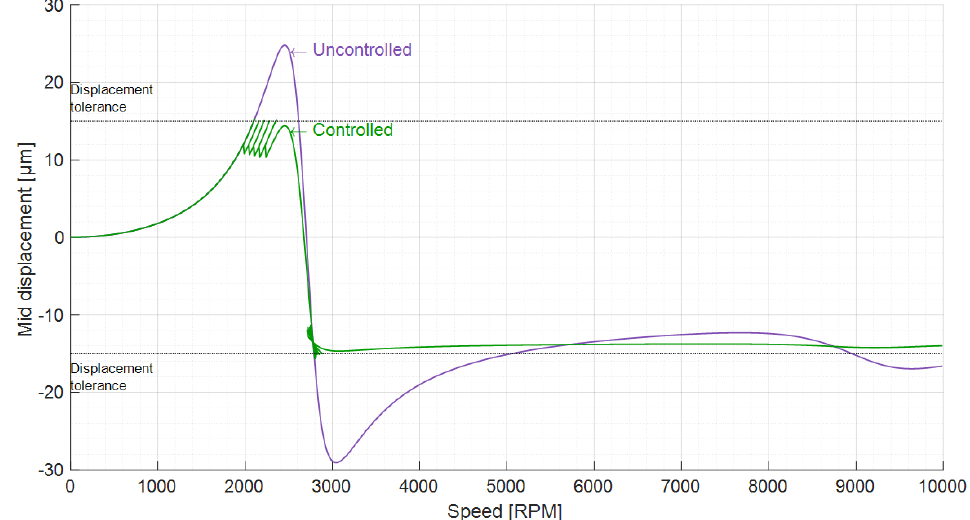
Figure 14. Adaptive algorithm action on the rotor mid-point radial displacement, with a 15 µ m radial displacement tolerance and a 12 µ m adjusting radial